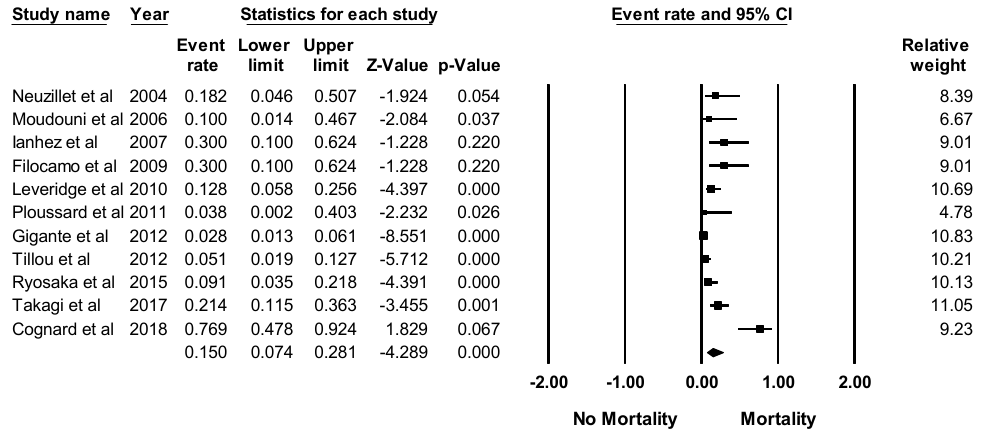
Figure 5. Forest plots of the included studies [13,14,16,17,19,20,23,30,33,36,39] assessing mortality rate in KTx recipients with RCC. A diamond data marker represents the overall rate from each included study (square data marker) and 95% confidence interval.